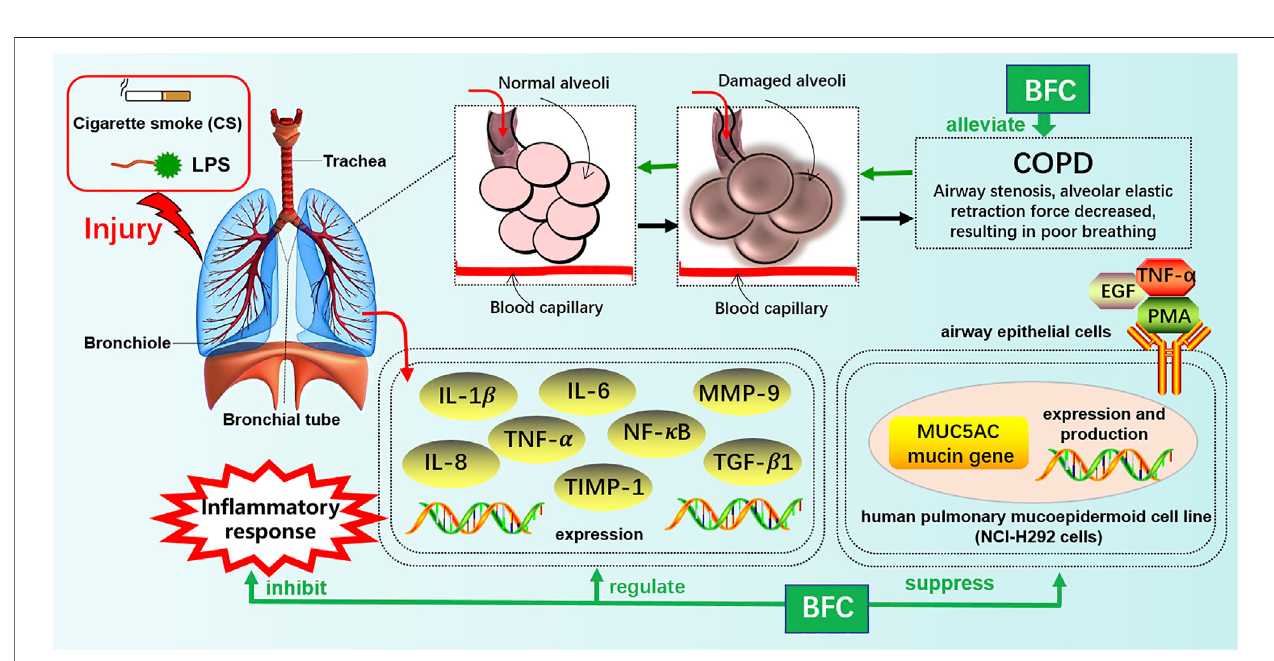
FIGURE 4 | The mechanism of BFC in the treatment of